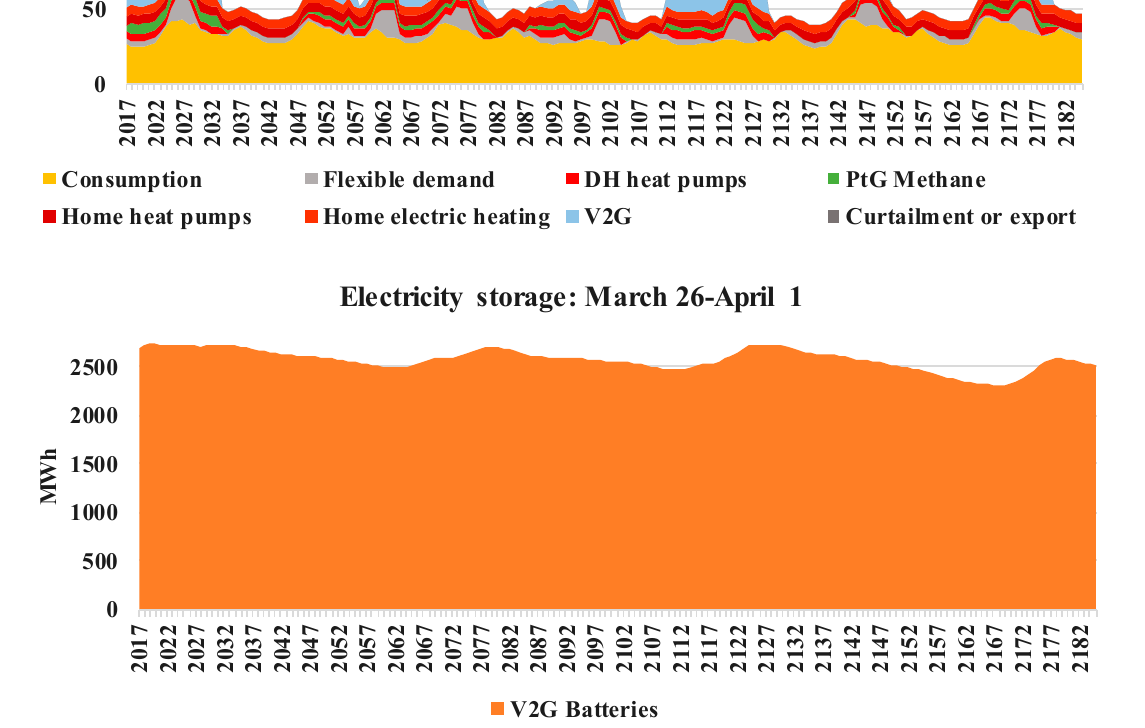
Figure 8. Electricity supply ( Top ), consumption ( Centre ), and storage ( Bottom ) for the first study period: 26 March–1 April. The beginning of the week shows the highest amount of variable RE generation. As storage options reached their capacities, some curtailment was needed. Daily cycles of charging and discharging of V2G storage are apparent over the week. These cycles are somewhat more prominent during days of lower wind generation. V2G charging is highly associated with solar PV generation throughout the week, creating a buffer between RE generation and end-use.